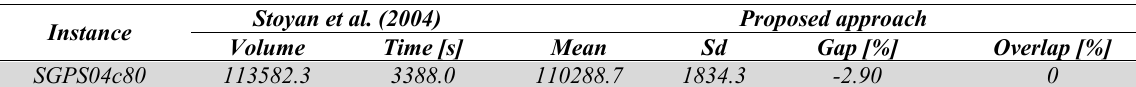
Fig. 16. Best solution obtained of the instance SGSPM05 c7 Results of the instance SGPS04 c80